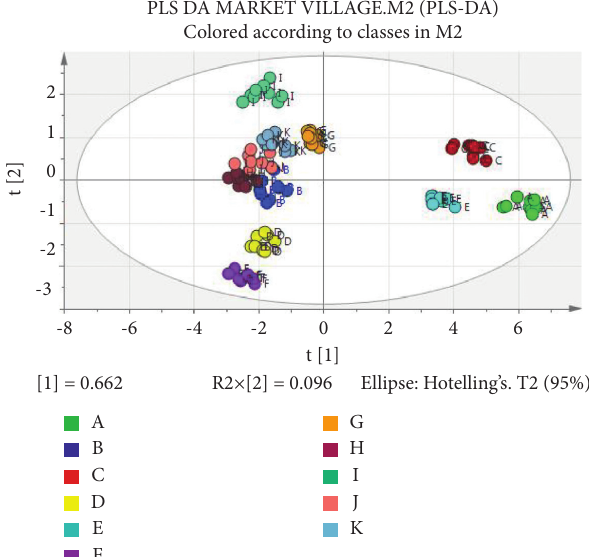
Figure 1: The partial least squares-discriminant analysis (PLS-DA) score plot of control and market samples of village chickens. Colored circles are represented by CVC � control village chicken (green); MVC 1 � market 1 (dark blue); MVC 2 � market 2 (ma- roon); MVC 3 � market 3 (yellow); MVC 4 � market 4 (light blue); MVC 5 � market 5 (purple); MVC 6 � market 6 (orange); MVC 7 � market 7 (brown); MVC 8 � market 8 (turquoise); MVC 9 � market 9 (pink); MVC 10 � market 10